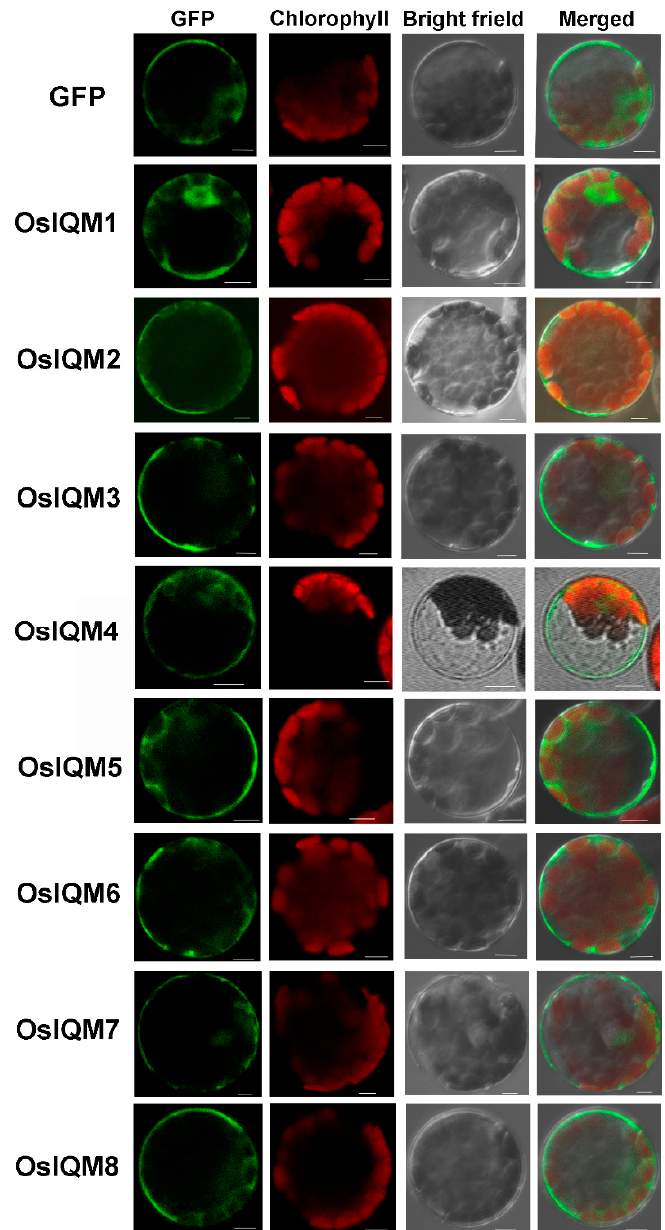
Figure 5. Subcellular localization of OsIQMs in Arabidopsis protoplasts. Bars = 5 µ m. Bright, bright- field image; GFP—GFP fluorescence image; Chlorophyll—chlorophyll autofluorescence; merged— merged bright-field, GFP fluorescence and chlorophyll autofluorescence images.